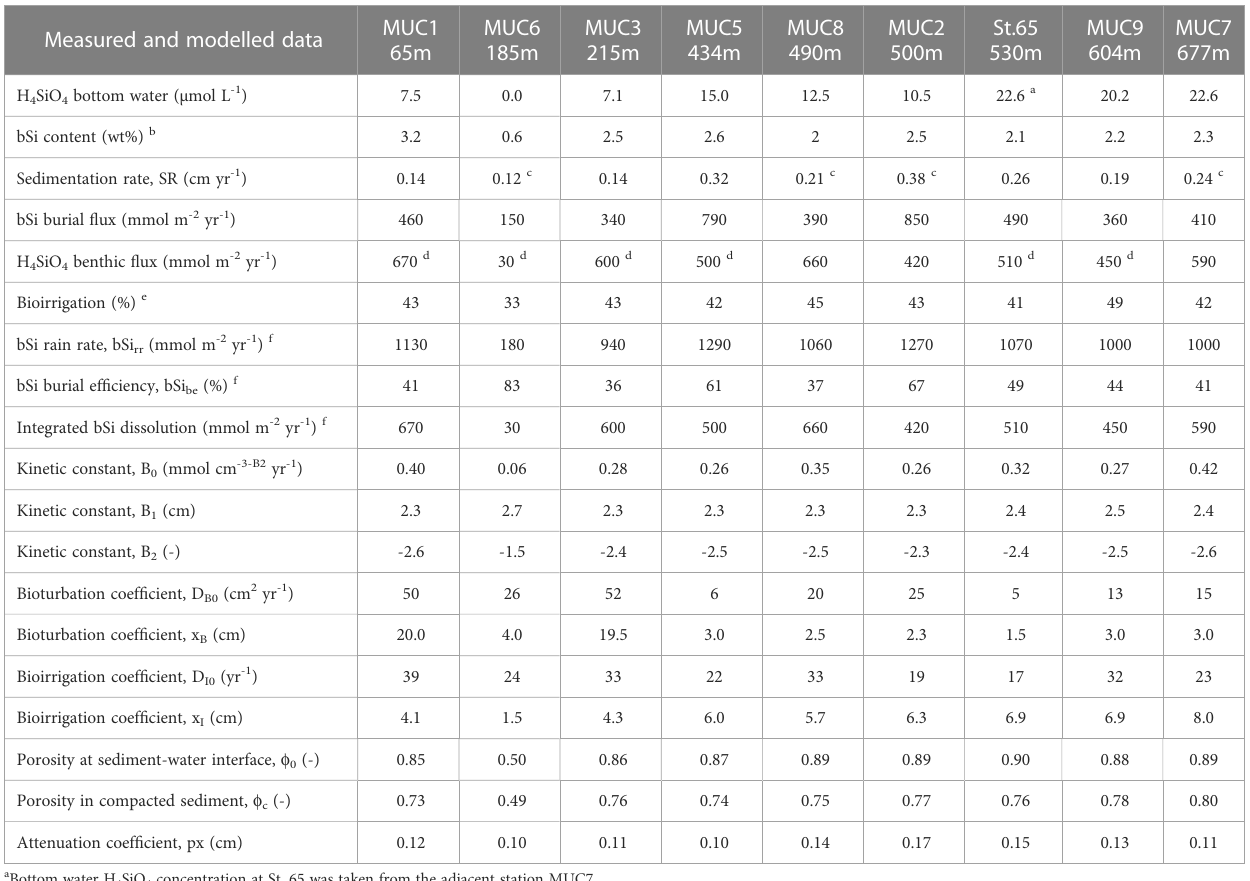
TABLE 2 Measured and modelled results for bSi